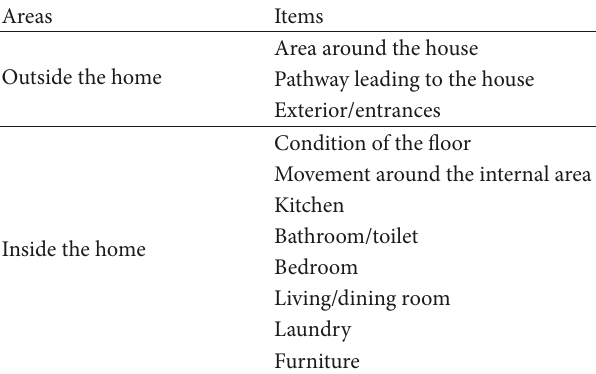
Table 1: Characteristics of the home-bound elderly ( 𝑁 = 66